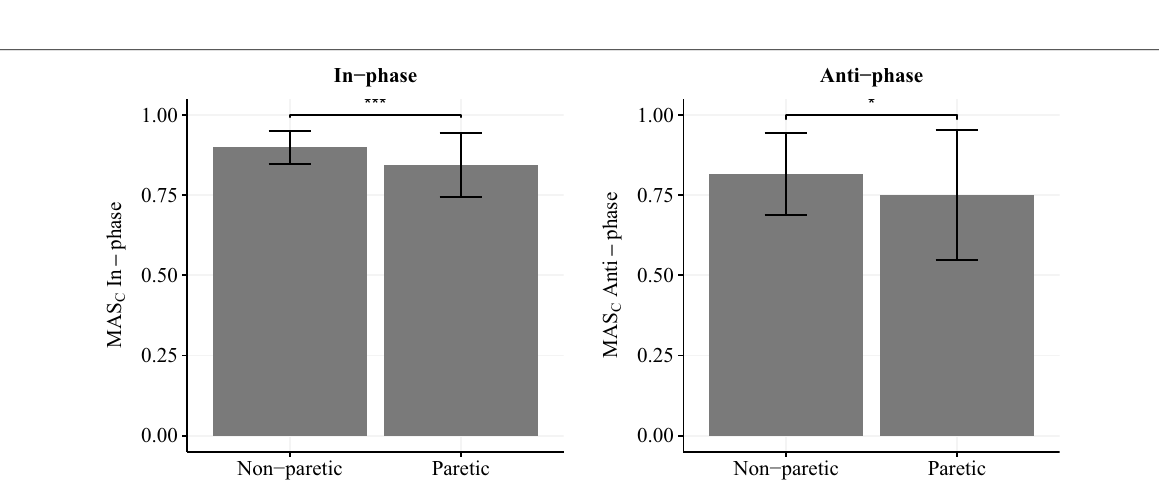
Fig. 9 Muscle activation similarity (MAS), a parameter comparing EMG similarity between coupled and uncoupled conditions, indicates lower similarity among tasks for the paretic side. The whiskers represent ±